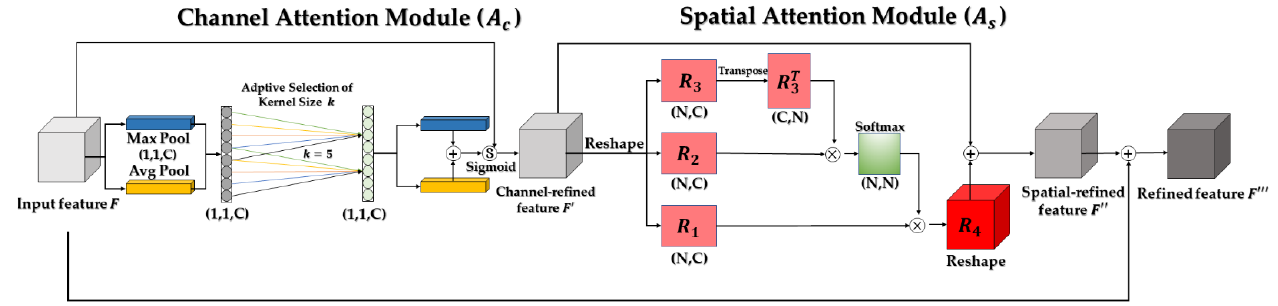
Figure 8. The overall structure of the lightweight non-local convolutional attention network (LNCA-Net) contains the original channel attention mechanism Ac and the modified channel attention mechanism As .